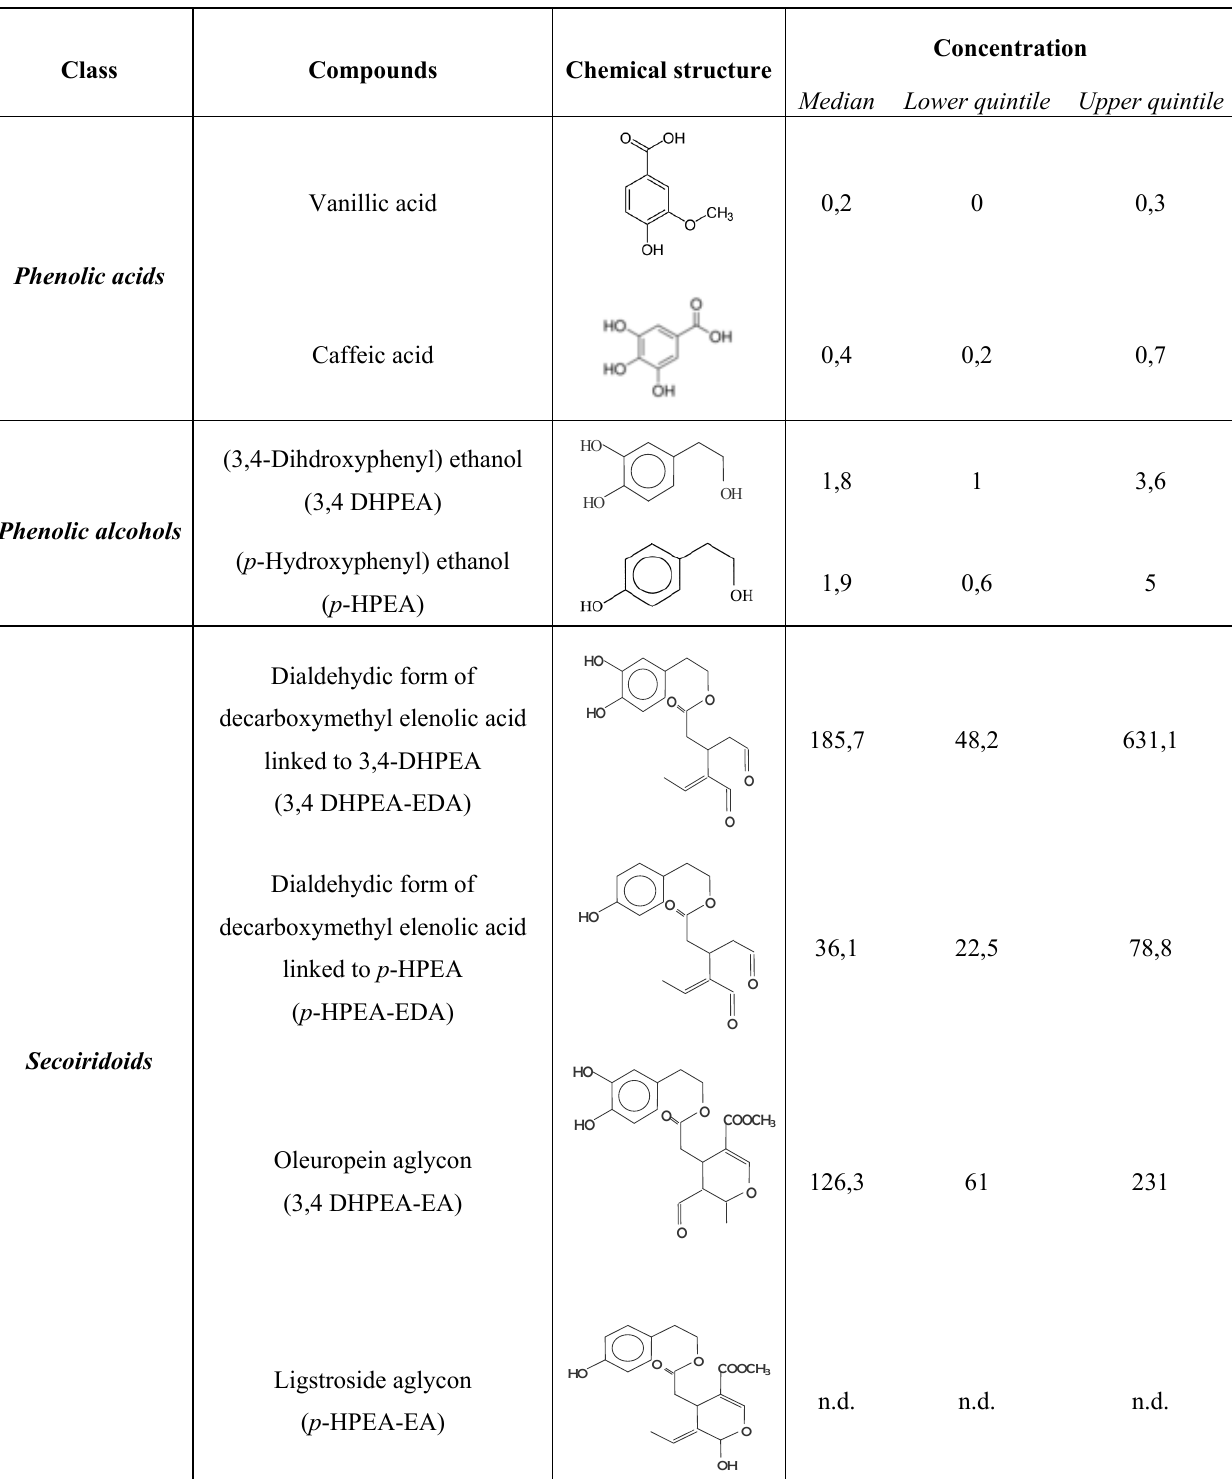
Table 2. Chemical structures and average values (mg/kg) of the prevalent phenolic alcohols, phenolic acids and secoiridoids of EVOO calculated using 210 oil samples obtained in industrial plants a